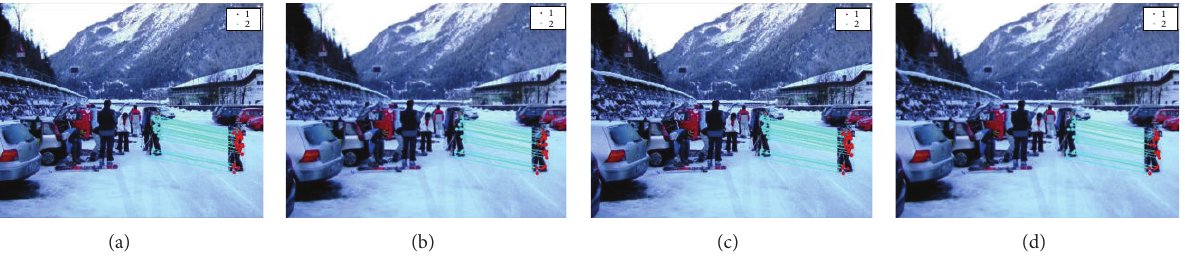
Figure 7: Copy paste detection results for blurring: (a) window size 5×5 , 𝜎 = 0.5 , (b) window size 5×5 , 𝜎 = 1 , (c) window size 7×7 , 𝜎 = 0.5 , and (d) window size 7 × 7 , 𝜎 = 1